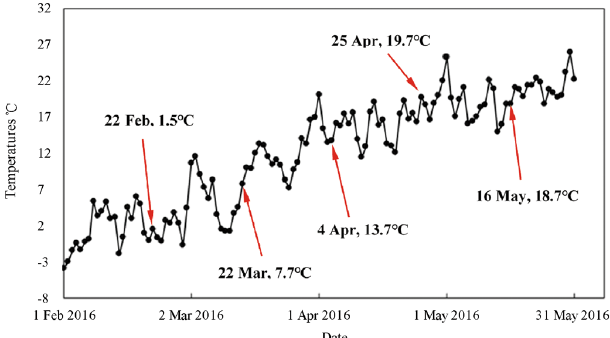
Figure 4. Changes in environmental temperature during the sampling